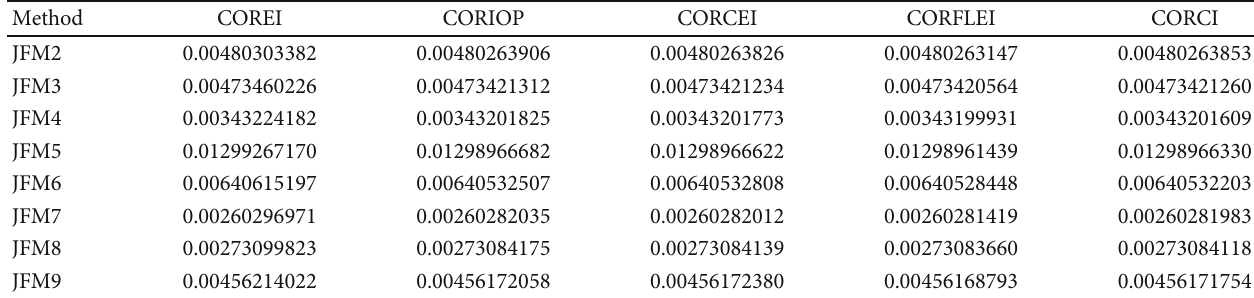
Table 37: Values of corrected e ffi ciency indices for the methods the second category to solve Test Problem 1, for n = 80 . Method